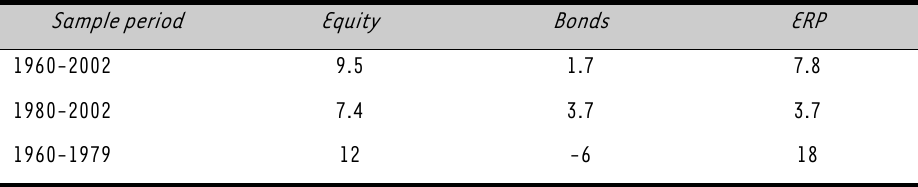
TABLE 1: Real returns, selected sub-periods Sample period